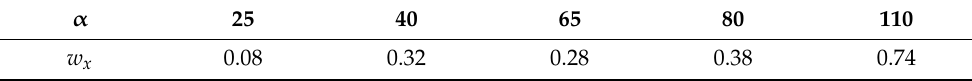
Table 5. w x values based on the spray